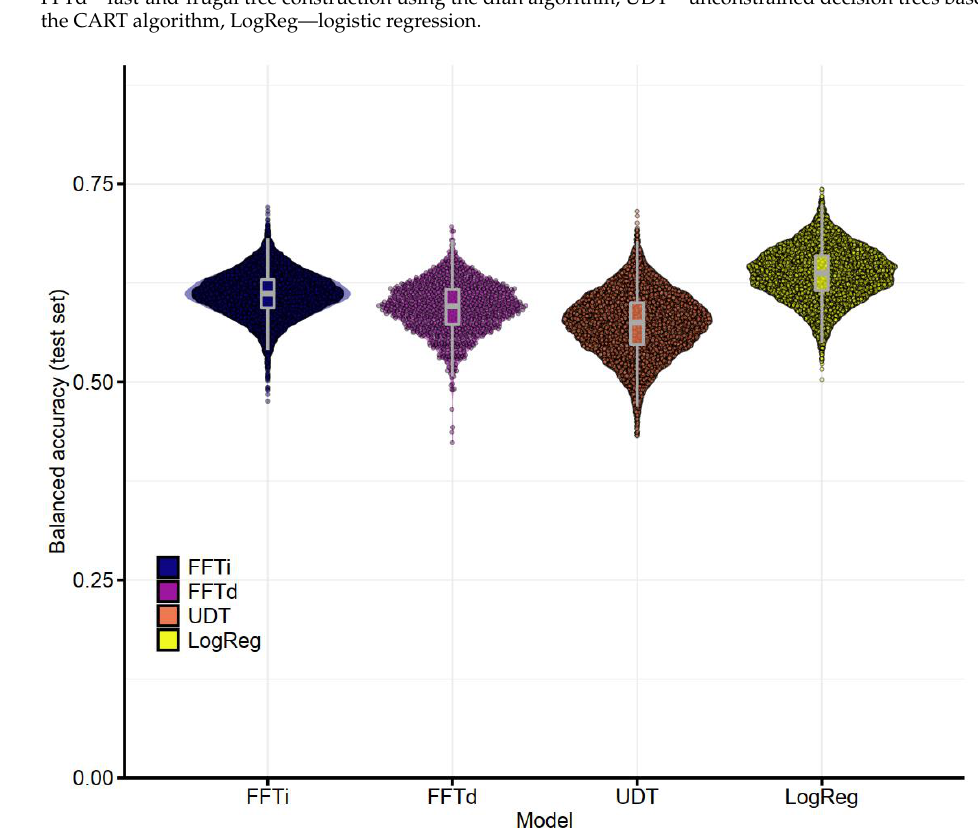
Figure 2. Balanced accuracy in the test set (prediction task) for the four algorithms across trials with pre-operative cues only. The graph shows boxplots and violin plots, with dots representing the results of individual trials (10,000 trials for FFTi, UDT and LogReg; 1000 trials for FFTd). FFTi—fast-and-frugal tree construction using the ifan algorithm, FFTd—fast-and-frugal tree construction using the dfan algorithm, UDT—unconstrained decision tree based on the CART algorithm, LogReg—logistic regression.